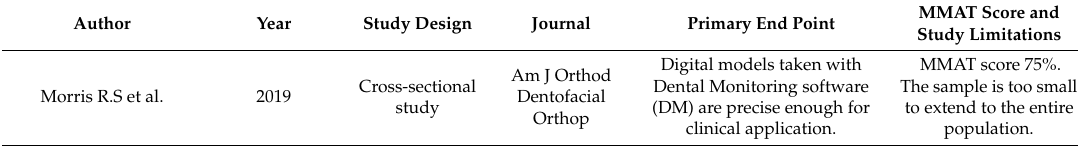
Table 1. Description of included studies and Mixed Methods Appraisal Tool (MMAT)